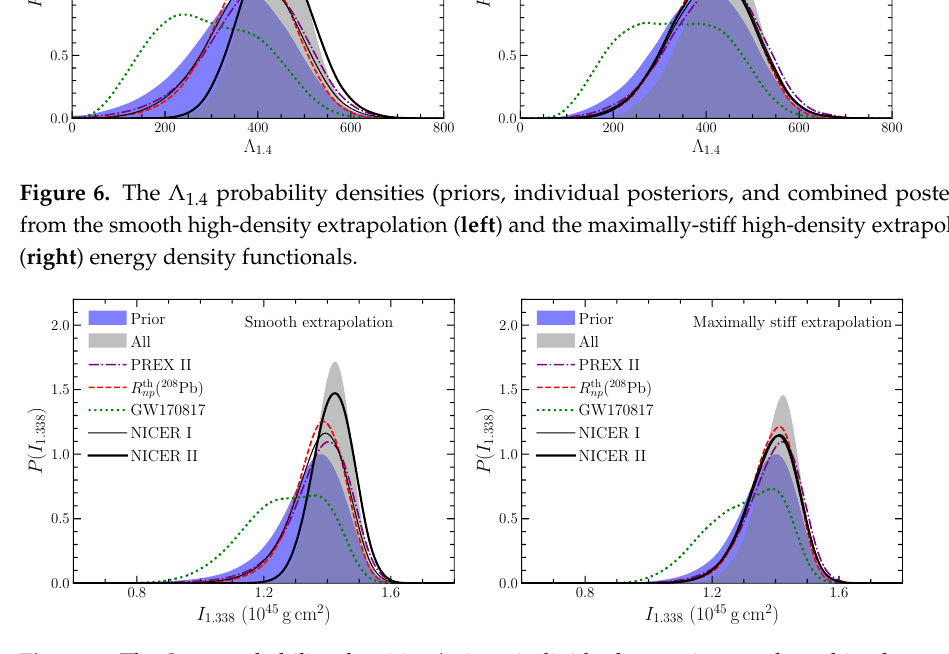
Figure 7. The I 1.338 probability densities (priors, individual posteriors, and combined posteriors) from the smooth high-density extrapolation ( left ) and the maximally-stiff high-density extrapolation ( right ) energy density